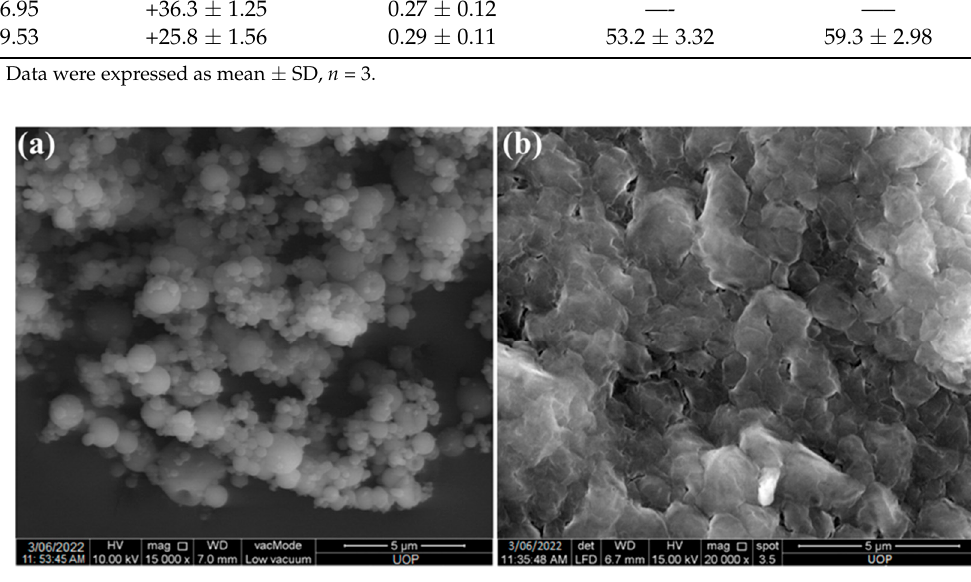
Figure 2. SEM image of ( a ) nanoparticles (Cur-Cs-Np) and ( b ) Patch (Cur-Cs-Np-P).